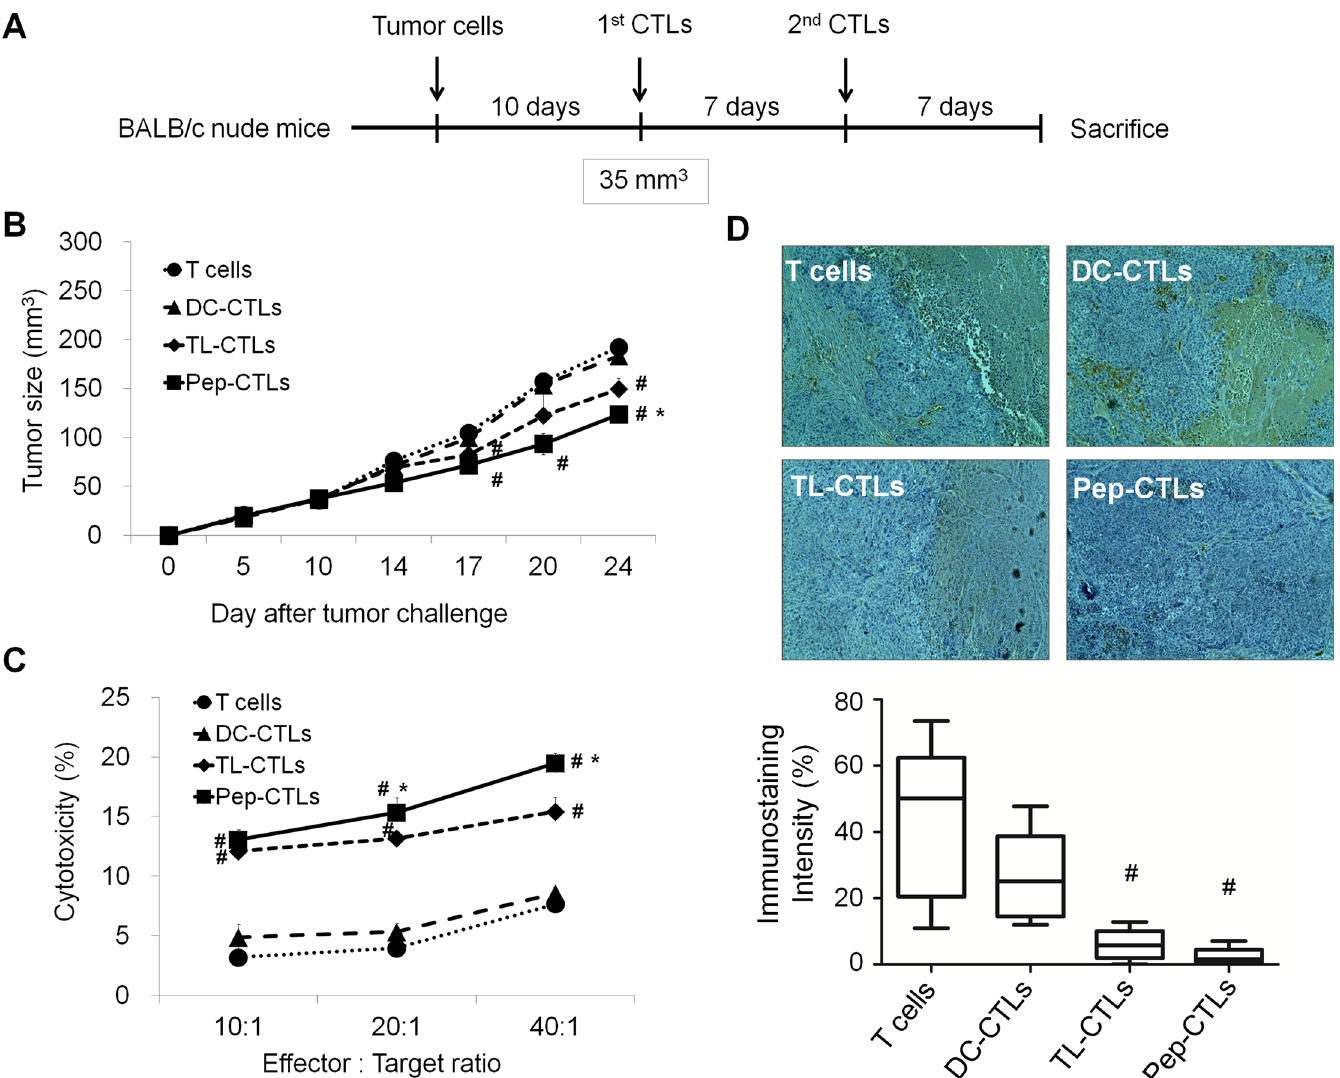
Fig 5. The antitumor efficacyof the EpCAM peptide-pulsed, DC-induced CTLs in HepG2 tumor-bearing mice. (A) The experimental setup and showingthe injectionschedulefor the tumor-associated antigen-pulsed, DC-induced CTLs. (B) Inhibitionof tumor growth analysis. Tumor-bearingBALB/c nude mice were treated with intravenous injections of Pep-CTLs (EpCAM peptidestimulatedDC-CTLs), TL-CTLs (HepG2 cell lysate stimulated DC-CTLs), DC-CTLs and T cells on days 10 and 17 after tumor implantation. (C) EpCAM + HepG2-specific cytotoxicity. Lymphocytes were isolated from the Pep-CTL-, TL-CTL-, DC-CTL- or T cell-treatedmice on day 14 post-inoculation. (D) Immunohistochemistry with anti-EpCAMantibodiesin HepG2 tumor tissue. Tumor regions of a section from a tumor isolatedon day 24 after tumor implantation. Original magnification, 200 × .The data are expressedas the mean ± SD,and significantdifferences betweenthe treated groupswere detected using ANOVA followedby the Dunnett’s test. # P < 0.05comparedwith the DC-CTLs, and * p < 0.05comparedwith the TL-CTLs.